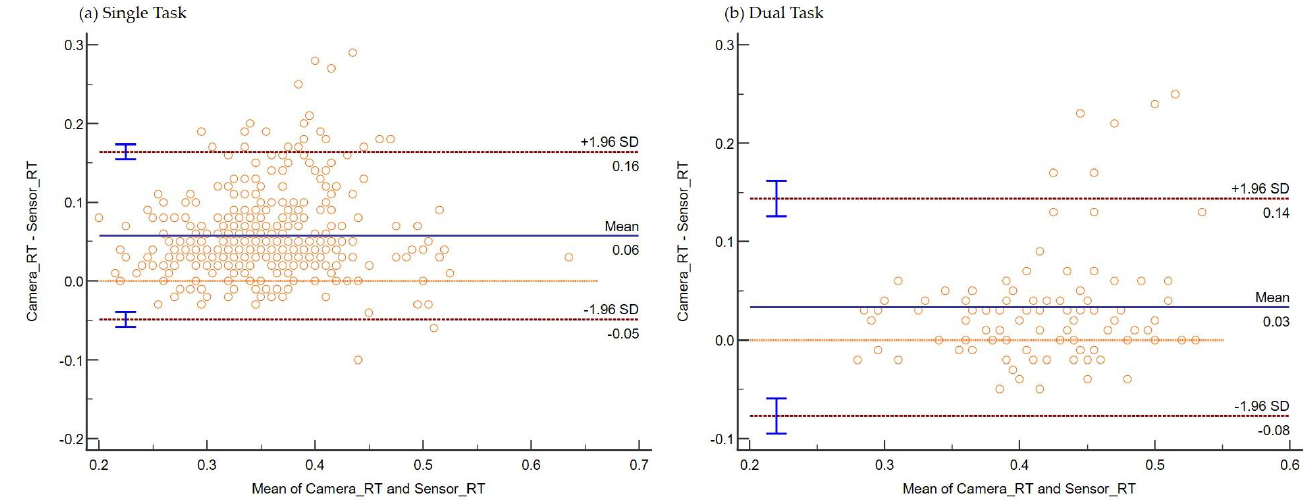
Figure 8. Plot differences between the camera and sensor systems RT versus the mean of two meas- urements for the overall trial with all conditions. Overall, camera systems were found to have a longer mean RT (bias) by 0.05 s.